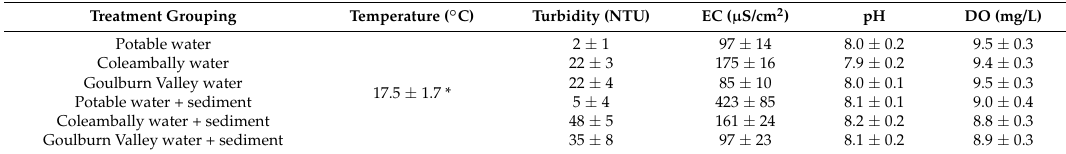
Table 2. Water quality data taken over the duration of the experiment. Values are mean ± one standard deviation. EC = electrical conductivity; DO = dissolved oxygen. All treatments with the same combination of water and sediment are grouped.